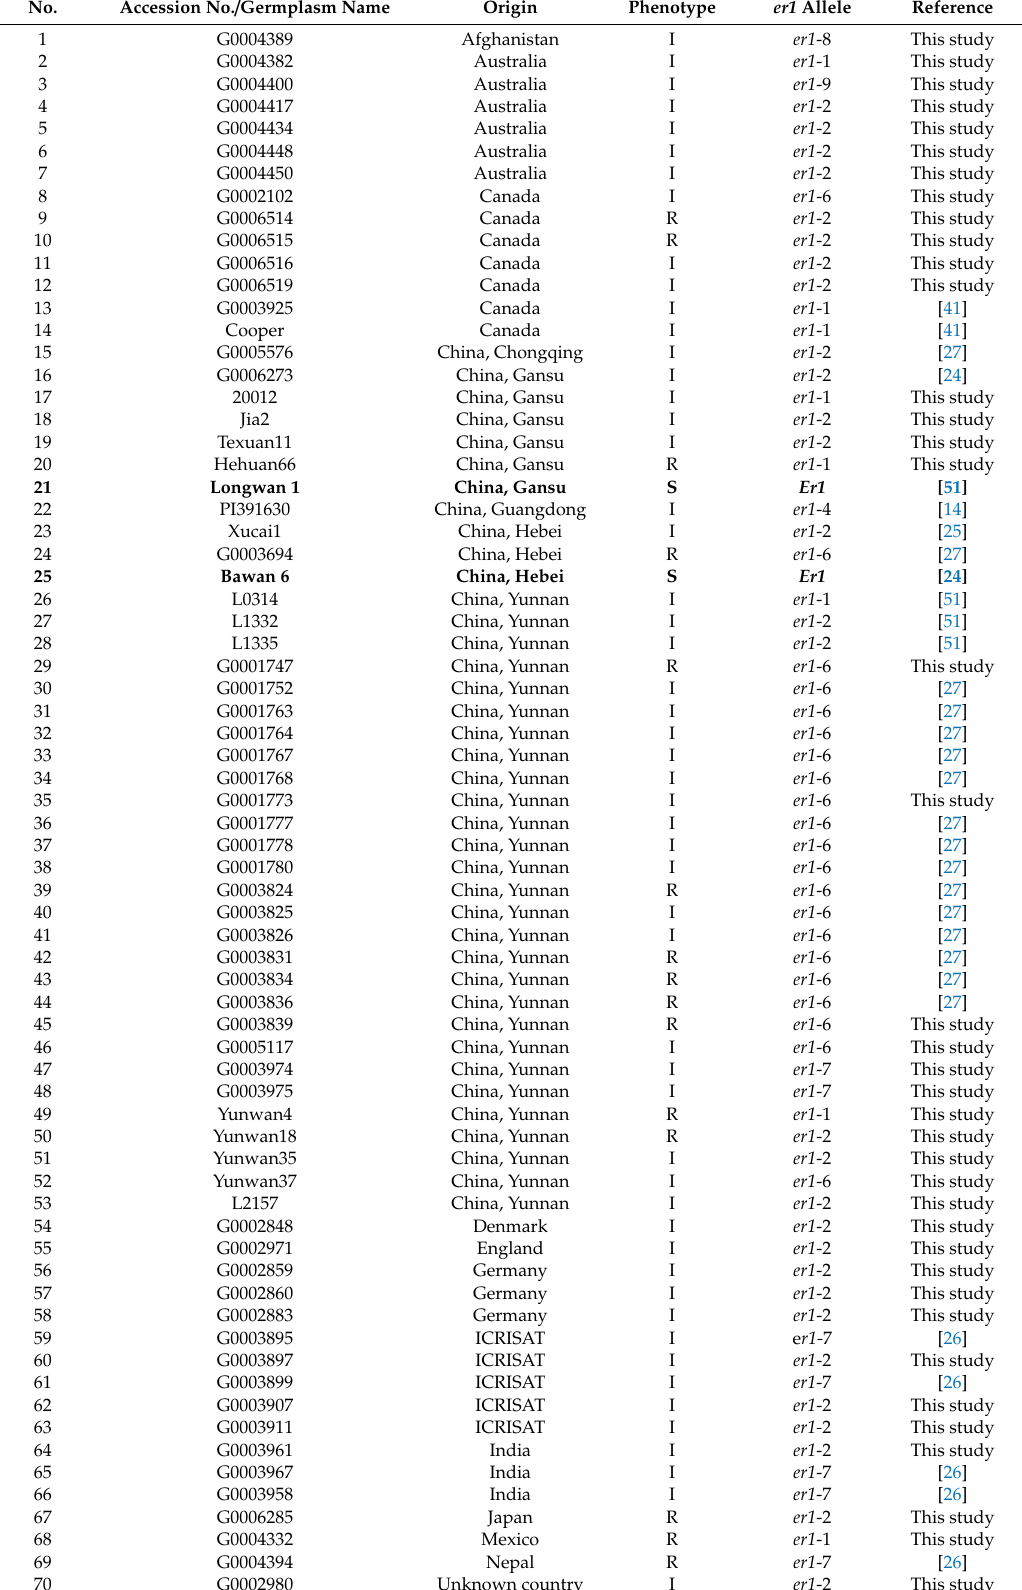
Table 1. Information about phenotype and the resistance gene at the er1 locus of the 86 Erysiphe pisi -resistant and the two E. pisi -susceptible controls (two controls are bolded).